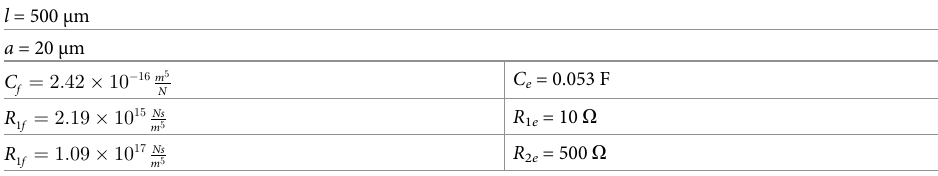
Table 2. Fluidic and corresponding electric characteristics of single tube